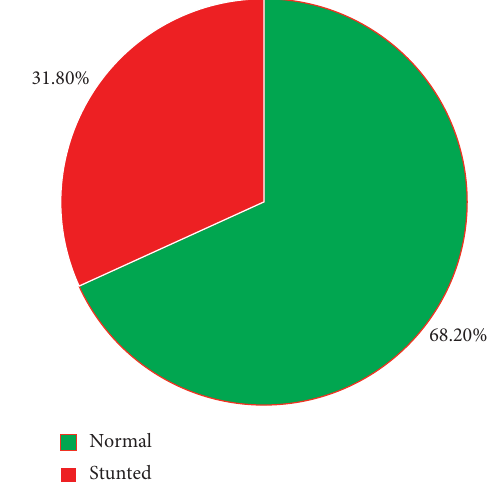
Figure 1: The prevalence of stunting among under-five children in the West Guji Zone, Oromia, Ethiopia, 2020.